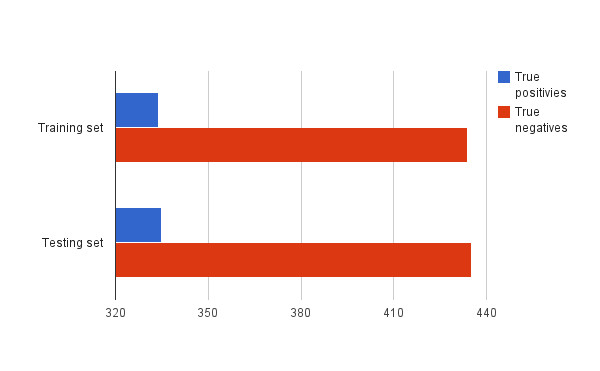
The ground truth.